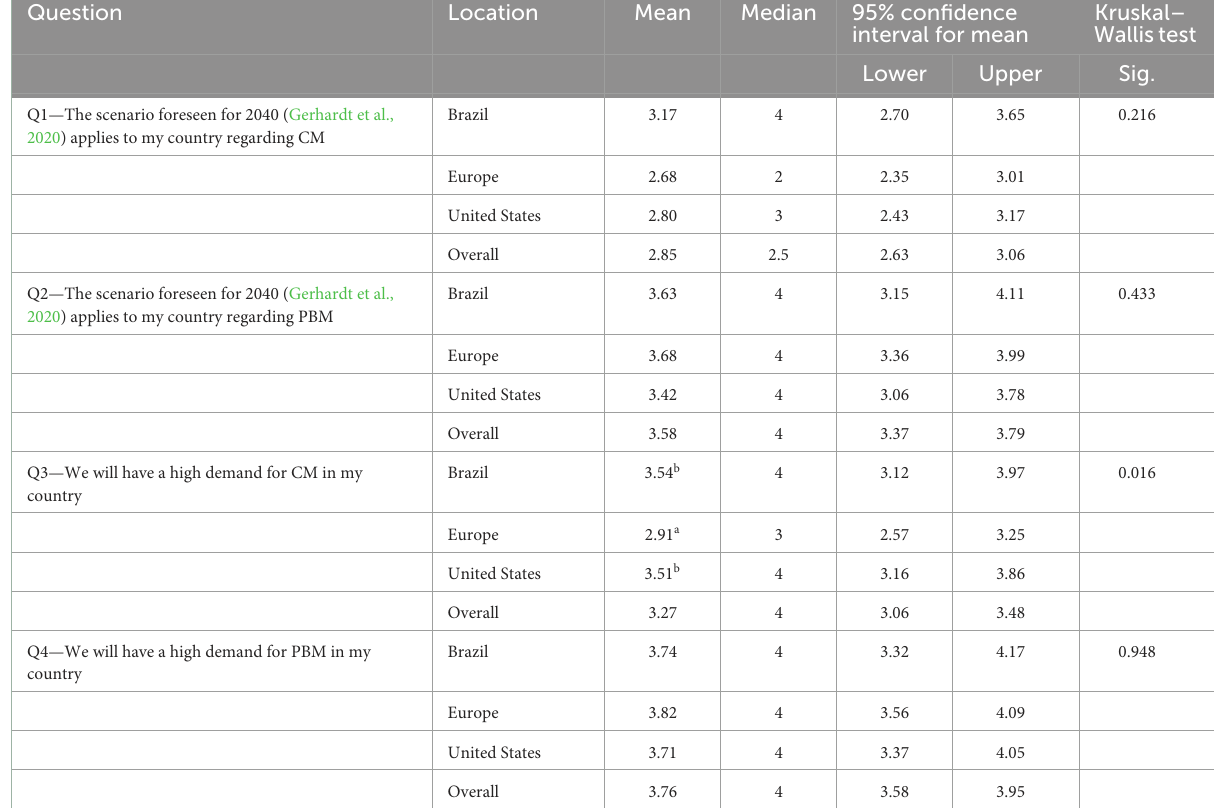
TABLE 2 Analysis for Q1–Q4 regarding marketing expectation in Brazil ( N = 35), Europe ( N = 56), and the United States ( N = 45), using Likert scale from 1 (strongly disagree) to 5 (strongly agree), as per interviews from August to October, 2021. Question Location Mean Median 95% confidence